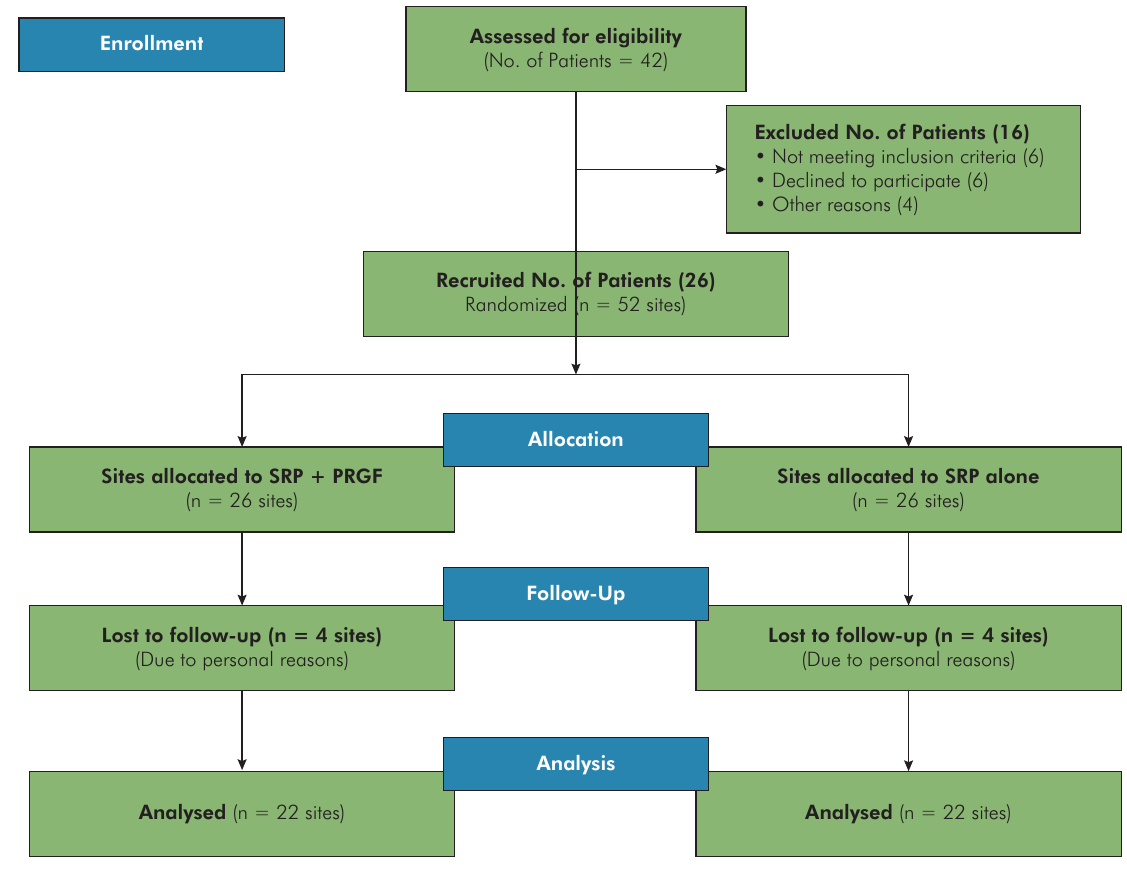
Figure 2. Consort flow